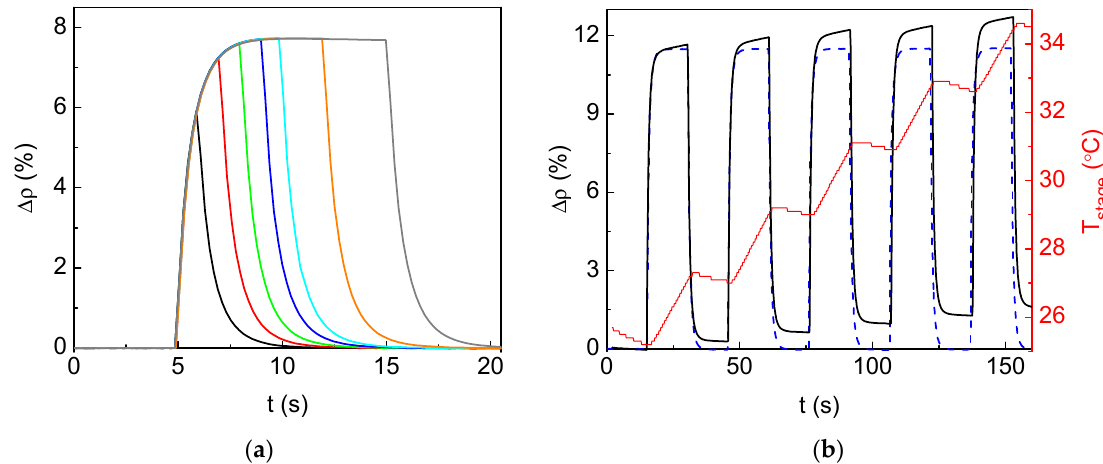
Figure A1. Percentage change of the resistivity at lighting by the blue laser on the epitaxial NNO film. ( a ) Optical power is set to 0.8 W, whereas the durations of the light pulse are varied as 1, 2, 3, 4, 5, 7 and 10 s. ( b ) Optical power is set to 1.2 W, whereas the temperature controller holds the temperature at 26 °C or does not operate. The reversible resistivity changes at the active controller are shown by blue dashed line. In the latter case, an additional increase in the resistivity shown by black line is accompanied by heating of the sample stage (reading of the inbuild thermocouple is shown by red line and referred to the right ordinate axis).